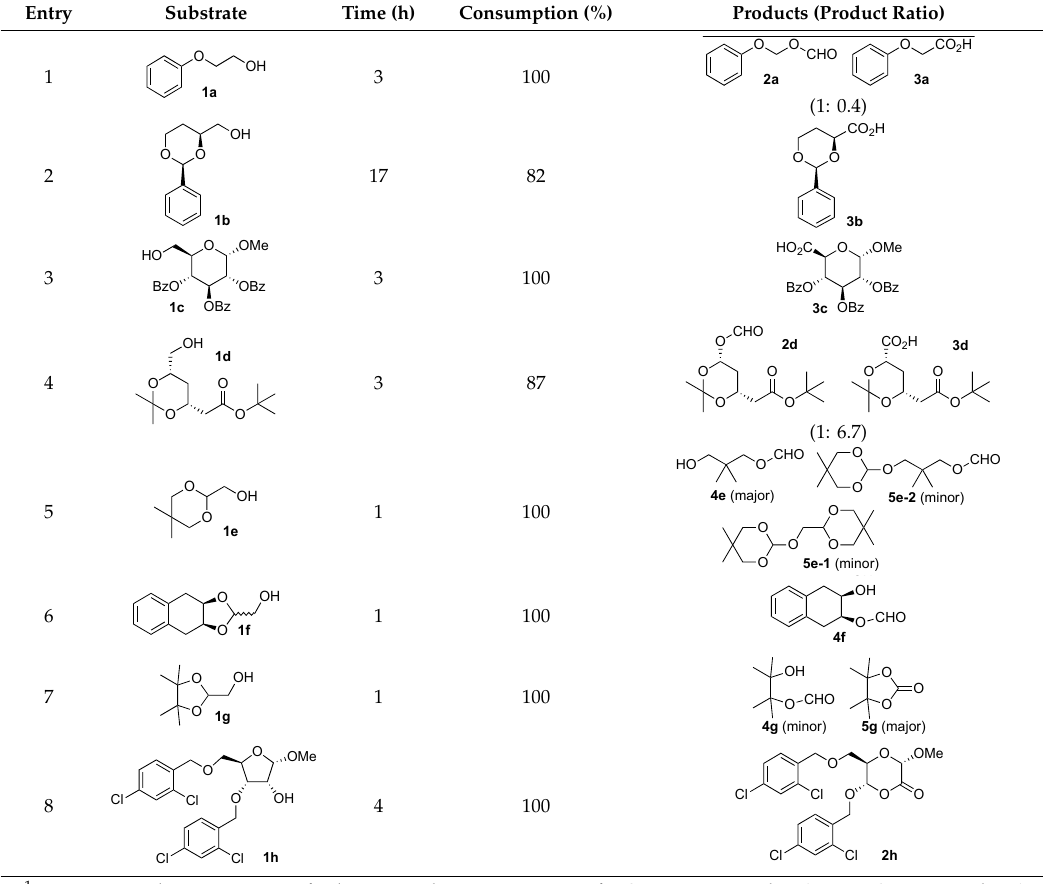
Table 1. Reactions of additional substrates under domino oxidation conditions. 1